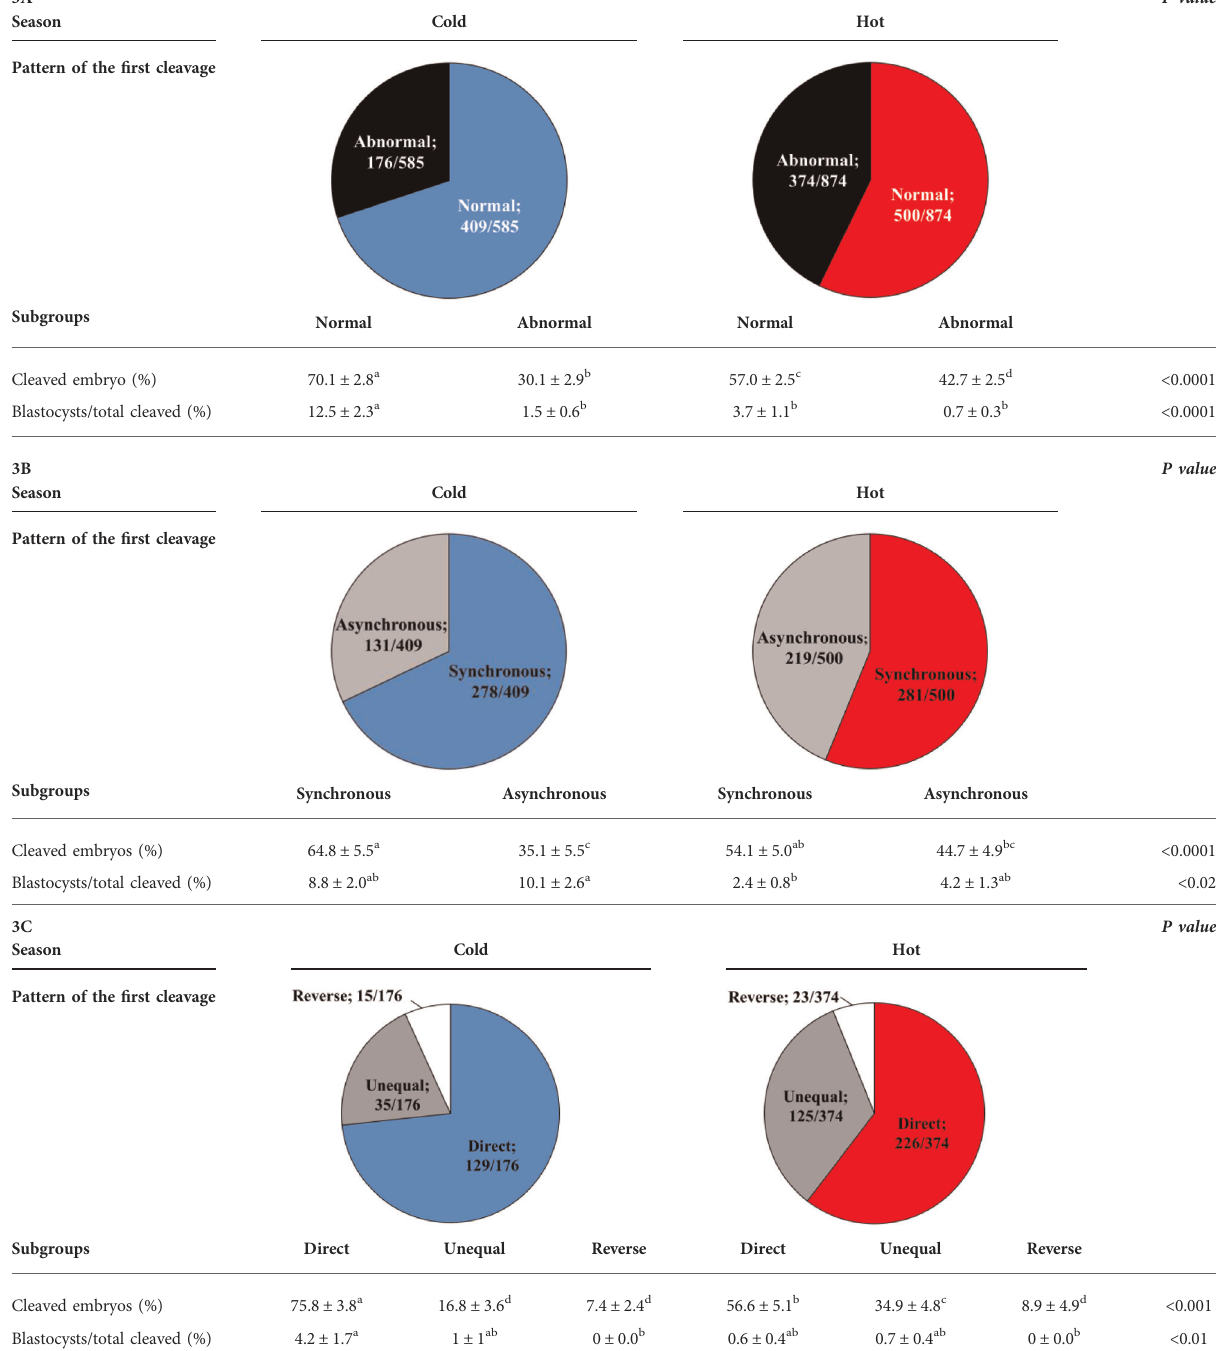
TABLE 3 Distribution of the cleaved embryos and blastocyst formation in normally and abnormally cleaving groups (3A) and subgroups (3B and 3C) during the cold and hot